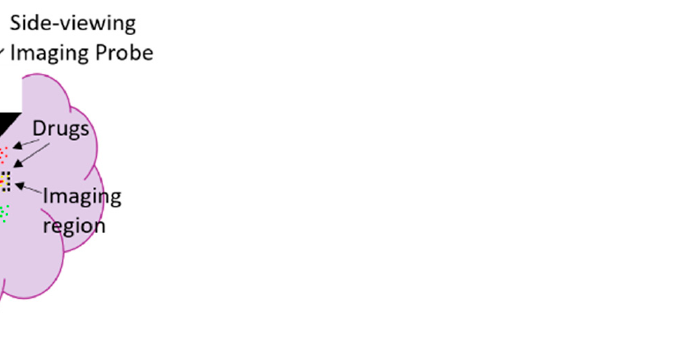
Figure 1. Schematic showing the implantable microdevice equipped with a side-viewing imaging probe.